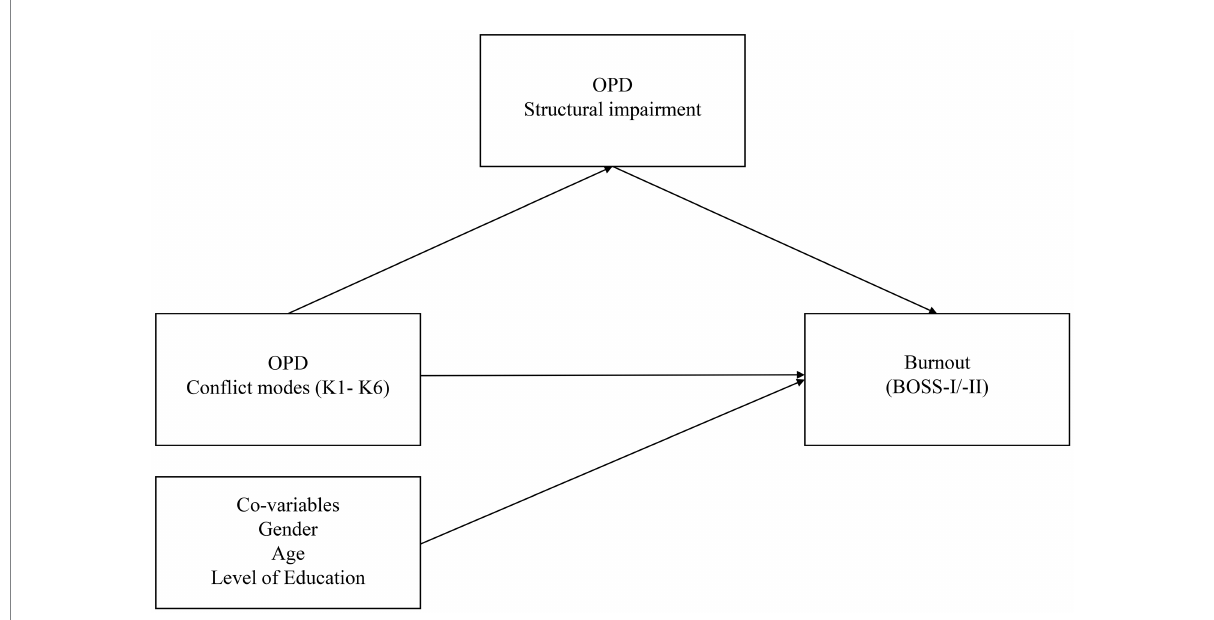
FIGURE 1 Theoretical model for the relationships between structural impairment, conflict modes and